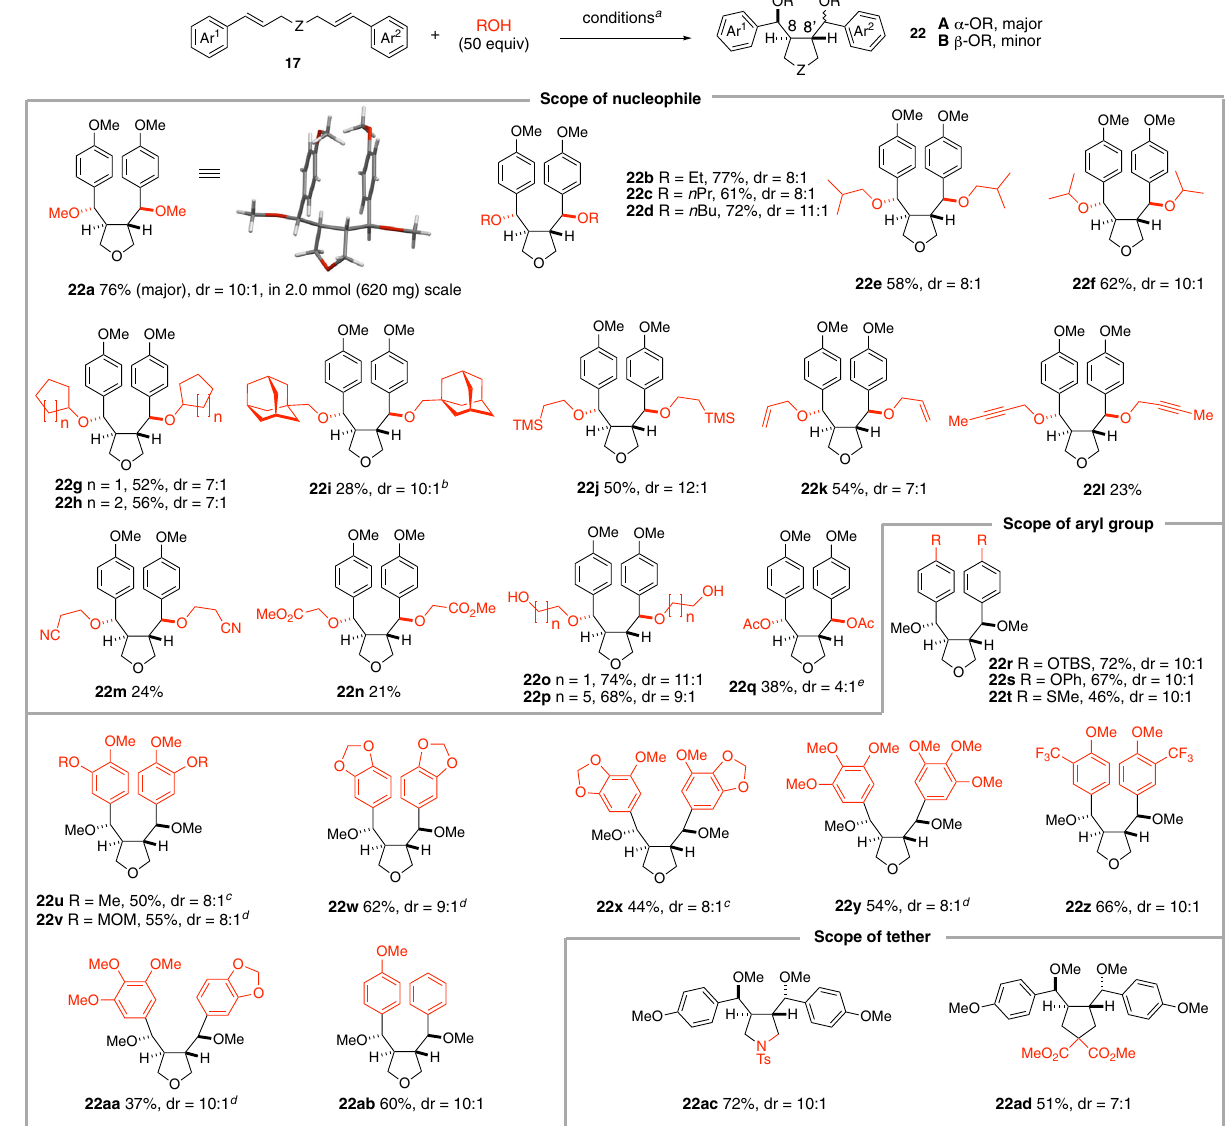
Fig. 5 Synthesis of C7,C7 ’ -dialkoxy dibenzyl tetrahydrofurans. Reagents and conditions: (a) 17 (0.1 mmol), [Mes-Acr-Me] + BF 4 − (5 mol%), Cu(TFA) 2 (cid:129) x H 2 O (0.12 mmol, 1.2 equiv), alcohol (5.0 mmol, 50.0 equiv), DCM (1 mL, c 0.1 M), 24 W blue LED, 23 °C. (b) 20 equiv of alcohol was used; c) Cu(TFA) 2 . x H 2 O (0.2 mmol) was used; d) AgTFA (0.2 mmol) was used as oxidant instead of Cu(TFA) 2 . x H 2 O; e) [Mes-Acr-Me] + BF 4 − (5 mol%),